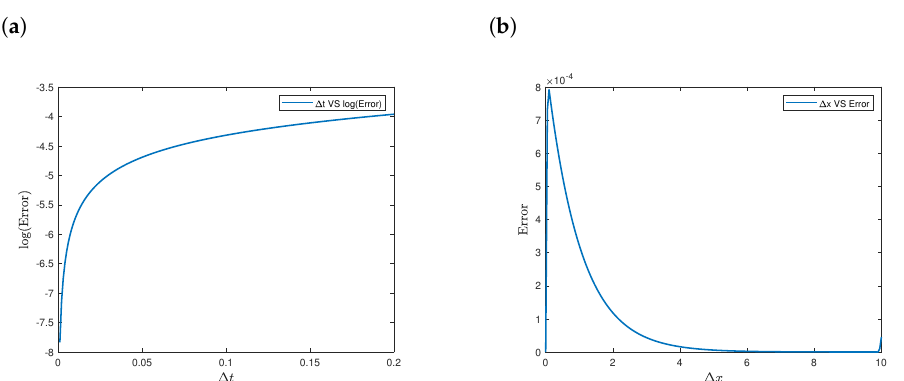
Figure 4. ( a ) Absolute error between the exact and EUPFD solutions of the linear ADR against time. ( b ) Absolute error between the exact and EUPFD solutions for the linear ADR against space.